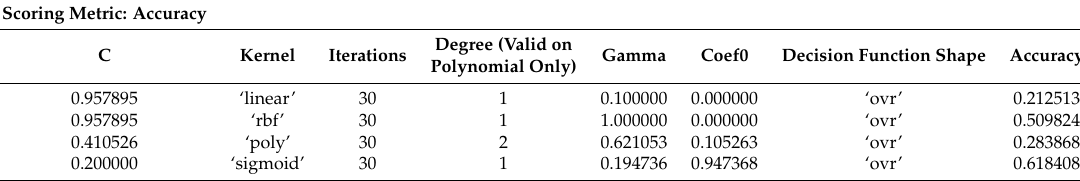
Table 1. SVM Parameters obtained using accuracy as the scoring metric (previously processed with multi-class PCA).